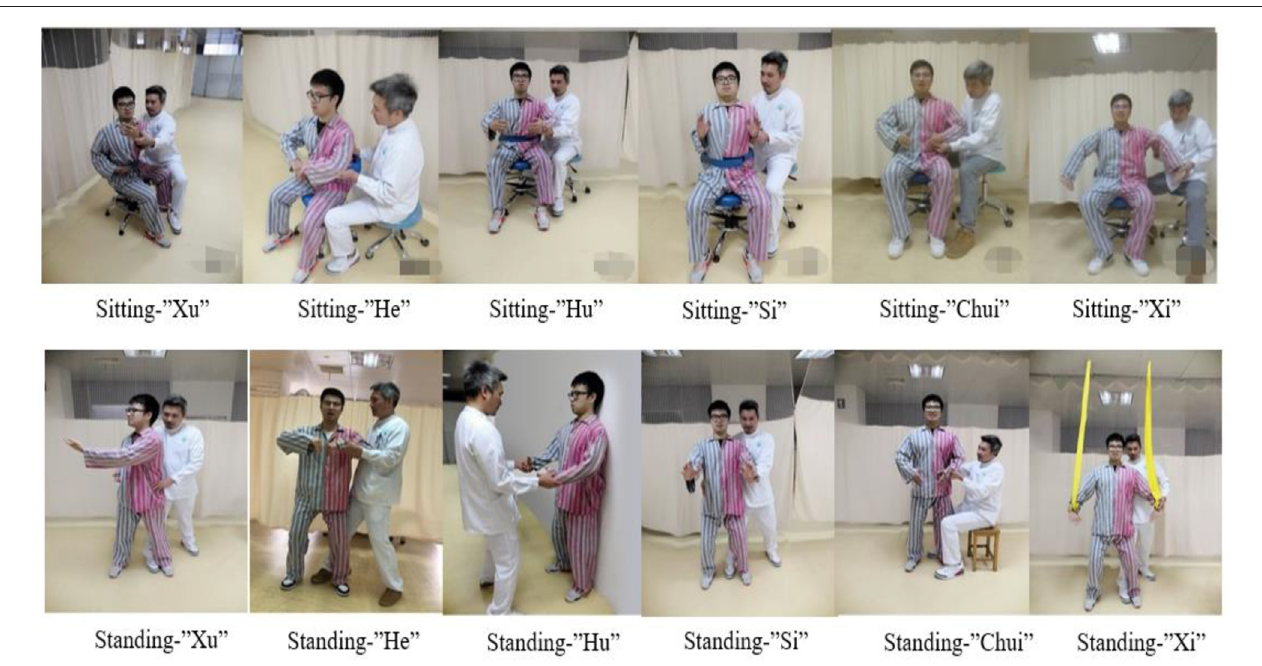
FIGURE 3 | The application of LQG movements in stroke patients. The diagram shows the application of LQG movements in a stroke patient. The therapist uses LQG movements for the stroke patient in the sitting and standing positions. In sitting position, the patient is unable to perform the upper limb detachment independently and requires the therapist to assist him/her with the upper limb guide movements. In standing position, the therapist assists the patient with trunk rotation and upper limb movements, and controls the knee joint to move the center of gravity up and down. Assistive devices, such as elastic bands, may also be used to perform upper limb movements with